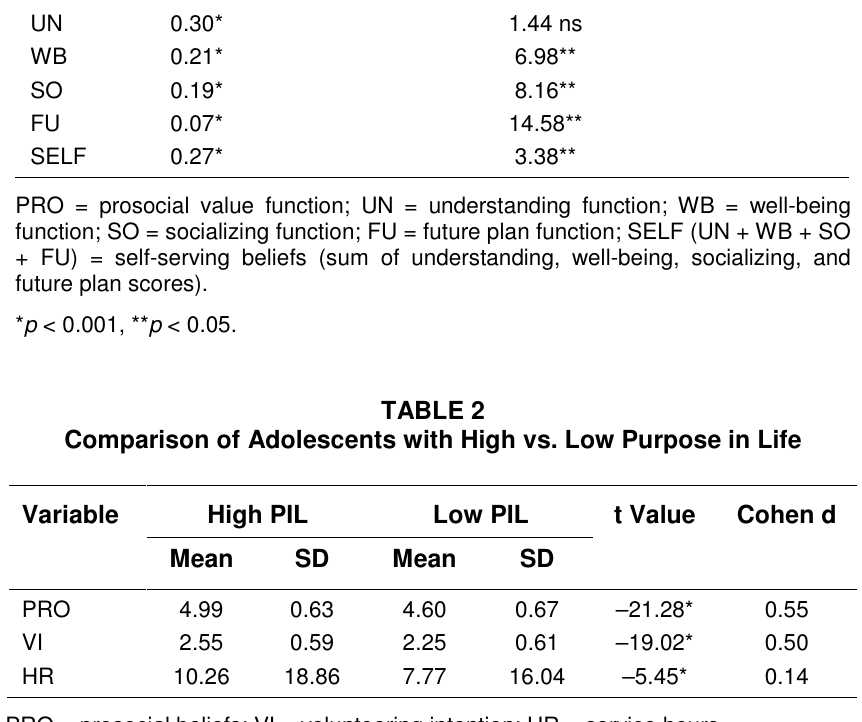
Relationship between Purpose in Life and Beliefs on Volunteerism Variable PIL Pairwise Comparison with PRO vs. PIL ( z Score) PRO 0.33* — UN SO SELF 0.27*